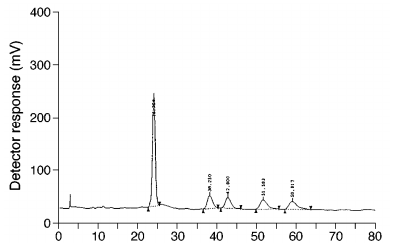
Figure 2. Chiral separation of α -Toc methyl ether by Chiracel OD column. Peak 1: four 2 S -isomers; Peak 2: RSS -; Peak 3: RRS ; Peak 4: RRR ; and Peak 5: RSR [28]. Reprinted with permission Copyright (1998) by Springer.